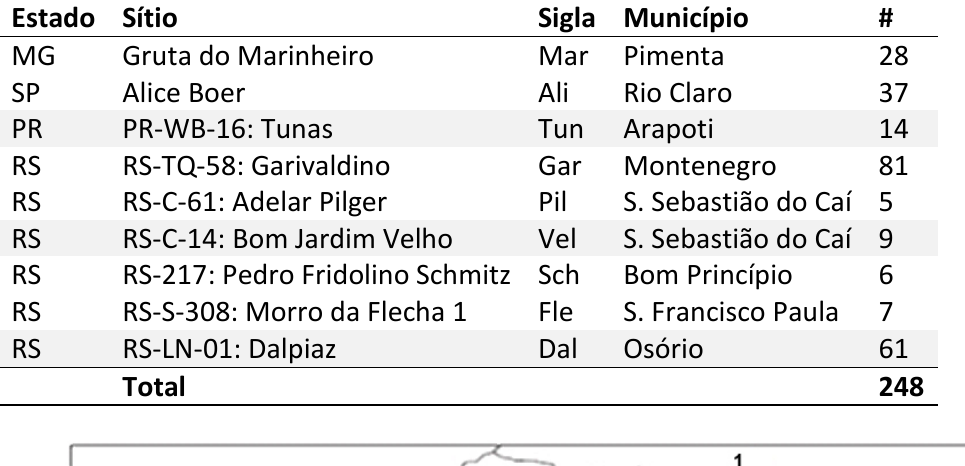
Tabela 1. Amostra utilizada para análise de morfometria geométrica. Table 1. Sample used for geometric morphometrics analysis.